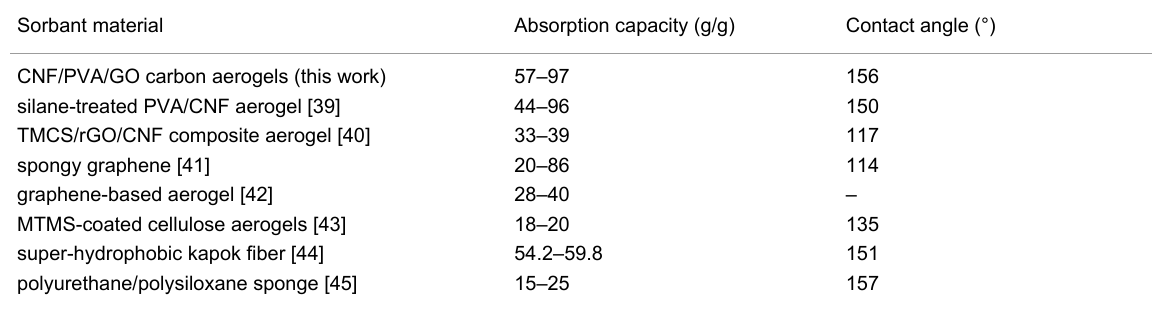
Table 1: Comparison of the absorption capacity and contact angle of different sorbent